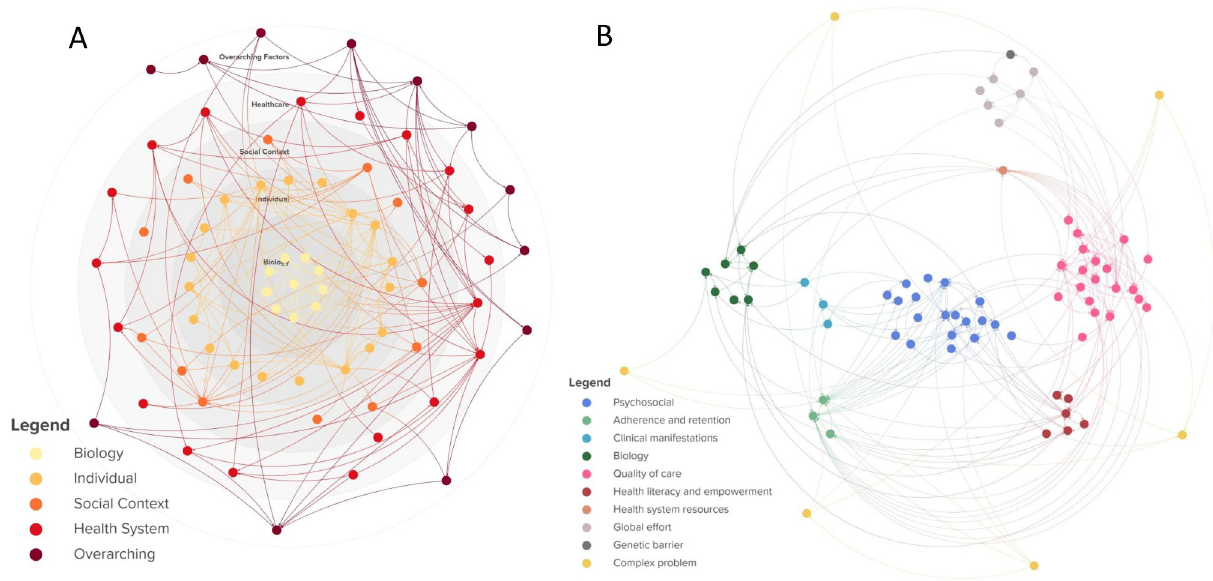
Fig 4. Different ways of visualizing a system. The elements and connections in A and B are exactly the same. In A the system is organized according to the different layers ranging from biology on the micro level to the individual level, the social context, the healthcare system and overarching factors at the macro level. In B, the elements are divided in thematic clusters and the relationships between clusters are visualized. Figure adapted from Kiekens et al. [19] and for illustrative purposes only.